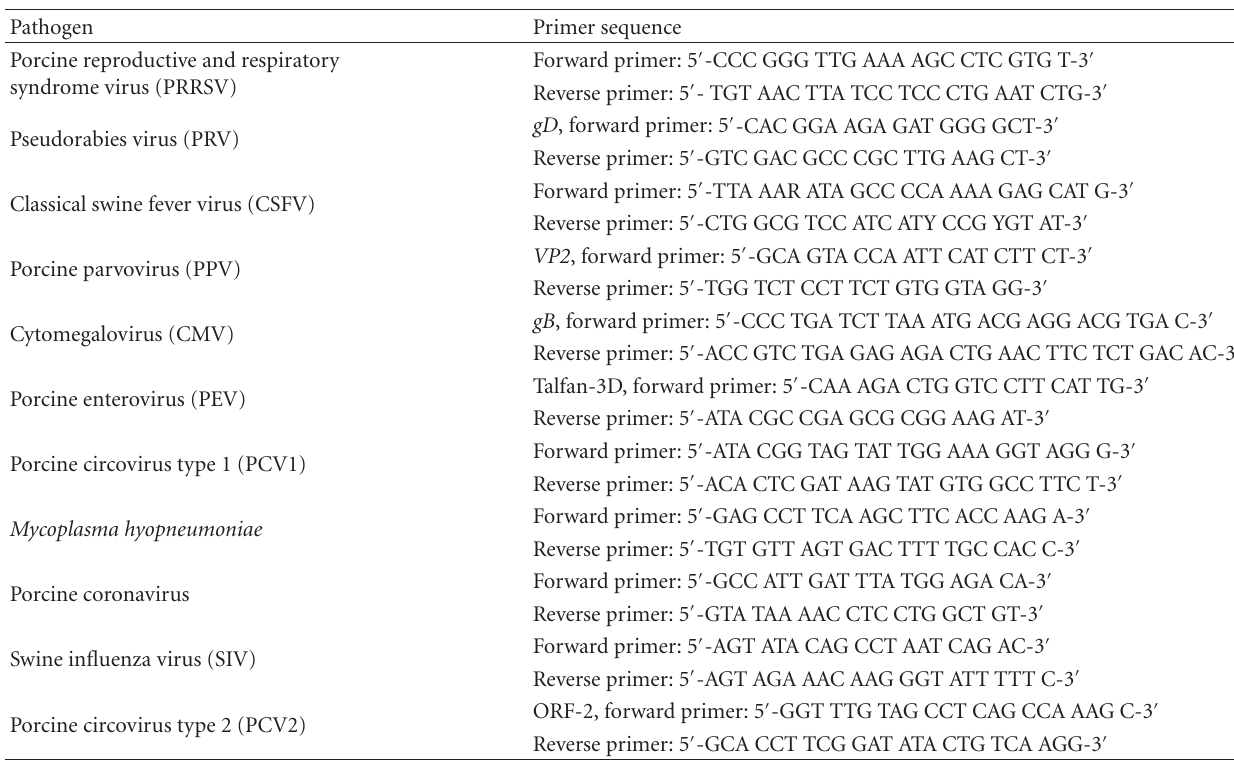
Table 1: Sequence of primers used for these pathogens detection by PCR analysis.